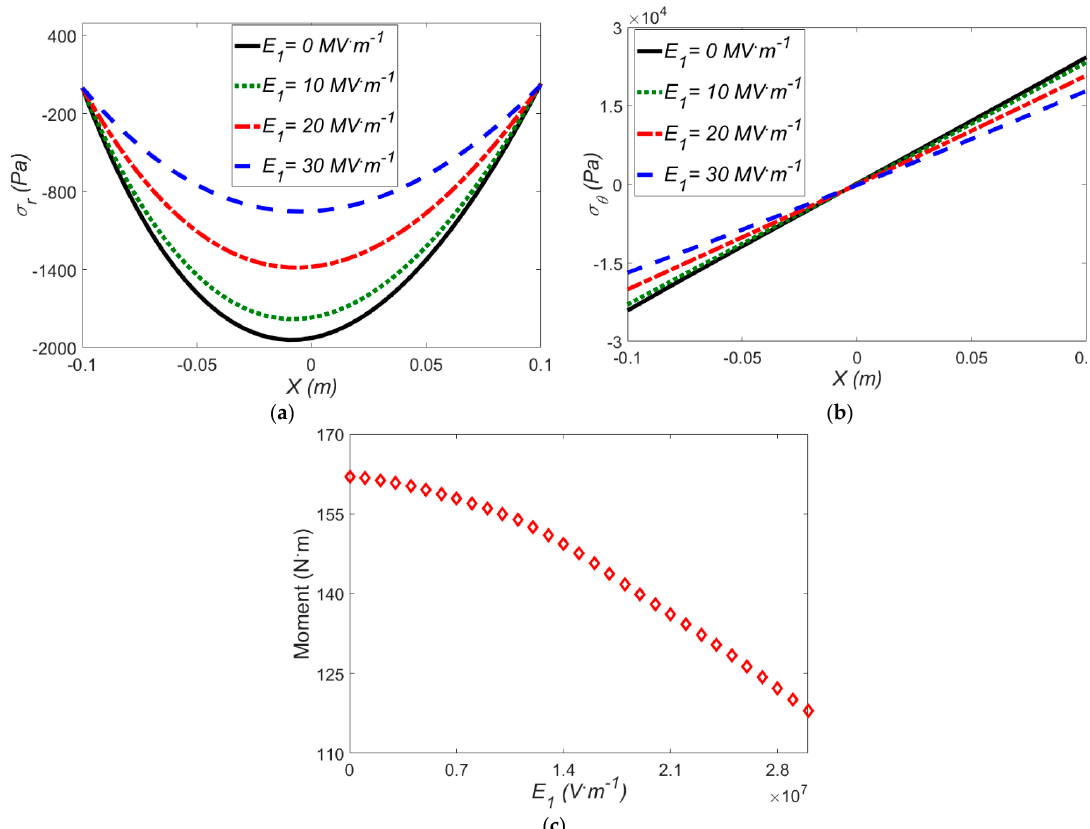
Figure 8. The effect of electric field on ( a ) radial stress; ( b ) hoop stress; ( c ) induced moment for Mooney-Rivlin model with ρ = 0.5 m and Δ T = 40 °C.